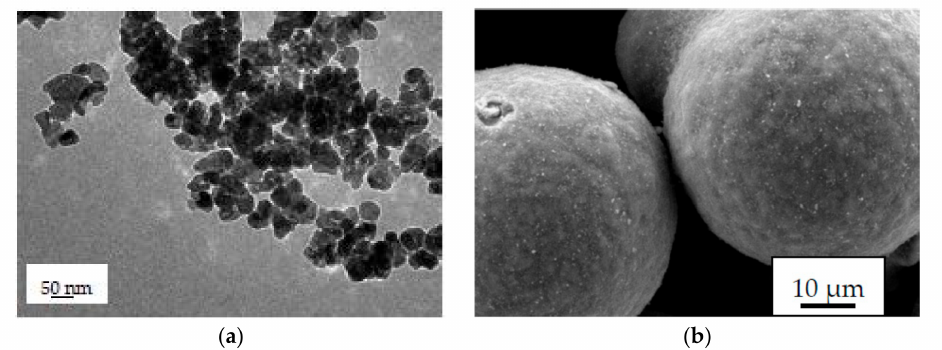
Figure 2. SEM micrographs of N-SiC powder ( a ) and AA6061 / N-SiC powder mixture ( b